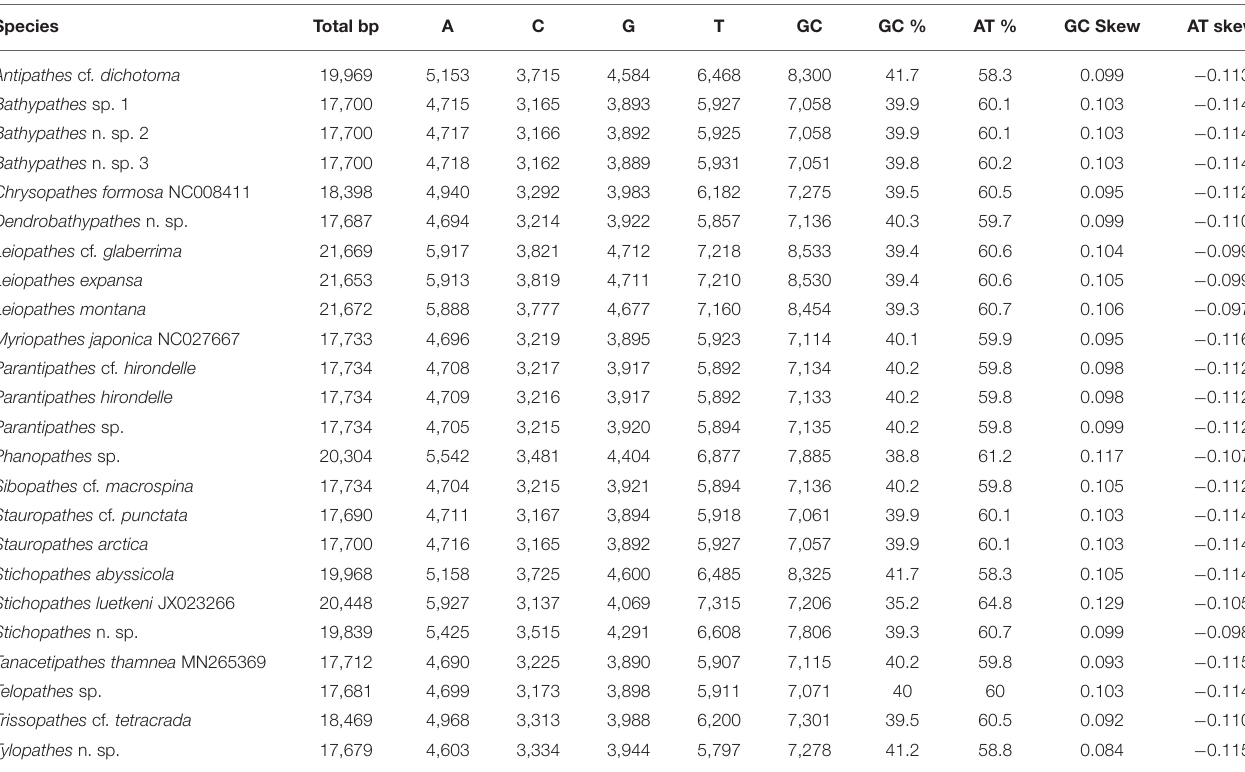
TABLE 3 | Antipatharian mitochondrial genome nucleotide compositions (from this study and GenBank species).